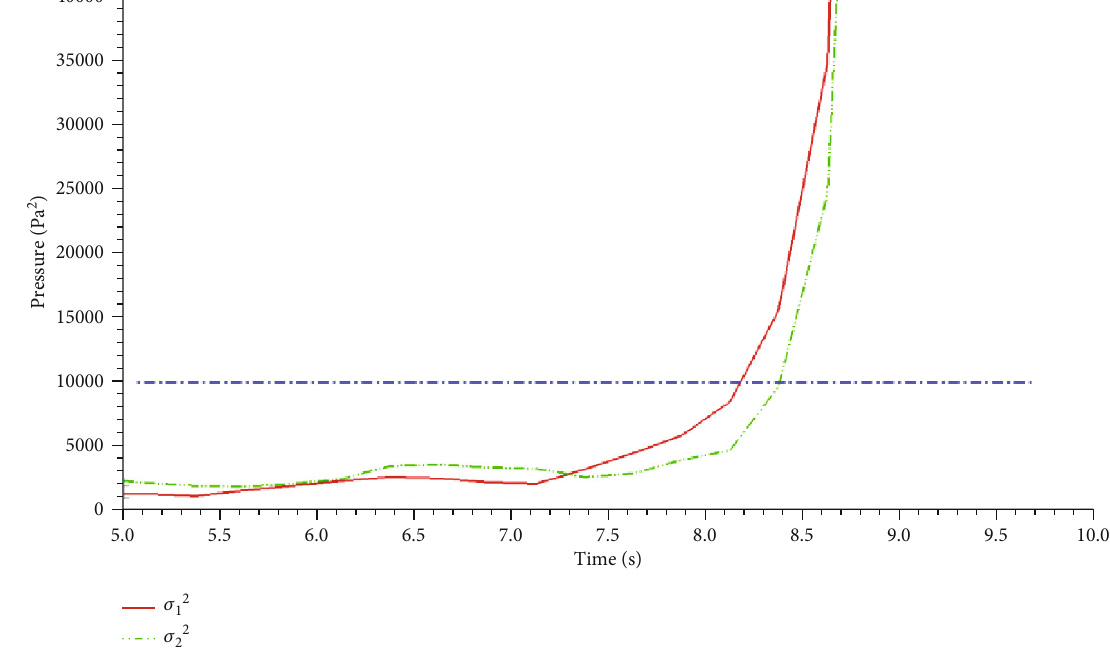
Figure 12: Analysis results of the heterotopic variance using measuring points of 0 ° and 180 ° in the circumferential